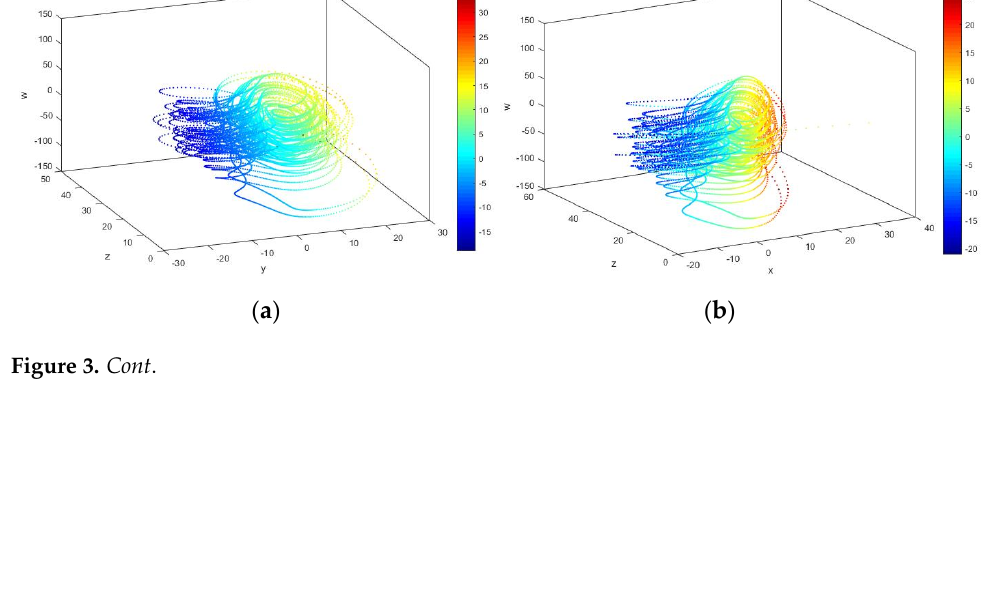
Figure 3. Phase diagrams of the Chen hyperchaotic attractor: ( a ) Phase diagram of the y − z − w plane; ( b ) Phase diagram of the x − z − w plane; ( c ) Phase diagram of the x − y − w plane; ( d ) Phase diagram of the x − y − z plane. 3.3. RNA Encoding Rules and Operations DNA and RNA are the core materials in the process of biological genetics. A DNA sequence is composed of four bases, namely A (adenine), C (cytosine), G (guanine), T (thy- mine), which are arranged in a certain order. An RNA sequence is also built of four nucleic acid bases. There is only one different base; that is, U (uracil) in RNA replaces T in DNA [43]. In the past several years, DNA coding technology is widely used in image encryption for its excellent characteristics in computing. In RNA coding, two binary numbers are mapped to one base under the designed coding rule. In biology, single-stranded RNA synthesizes its complementary strand according to the principle of complementary base pairing and then forms double-stranded RNA [43]. Based on the above discussion, we adopt RNA coding and operation in this paper, A and U are complementary, and C and G are complementary. Following the RNA complementation rules, we can only get eight coding rules shown in Table 2. Table 2. Binary coding rules for RNA sequences.